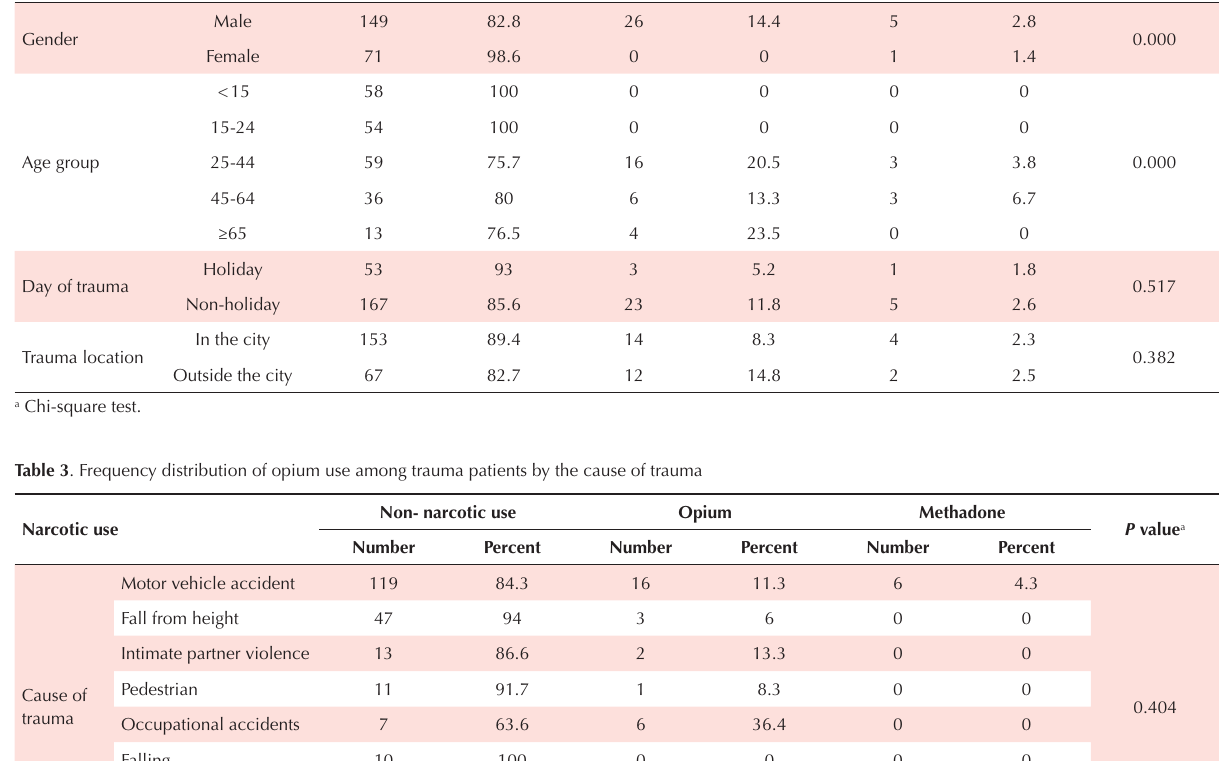
Table 2. Frequency distribution of trauma patients Narcotic use